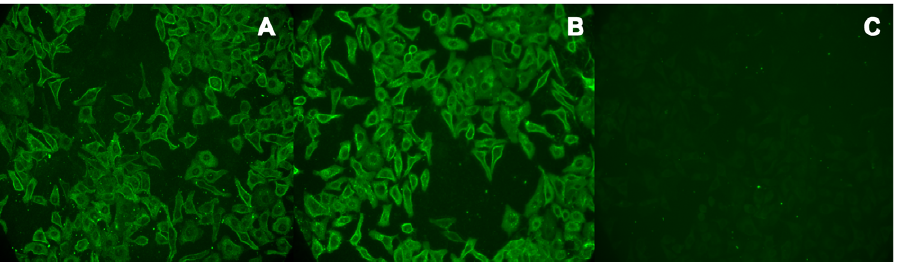
Figure 5. Adherence of rHX1 and rHX2 to HEp-2 cells. HEp-2 cells were incubated with (A) rHX2, (B) rHX1, and (C) PBS-BSA (negative control), and after washing, cells were incubated with rabbit antiserum to rHX2, antiserum to rHX1 and PBS-BSA, respectively. Then, HEp-2 cells were labeled with anti-rabbit IgG-FITC and examined by fluorescence microscopy.